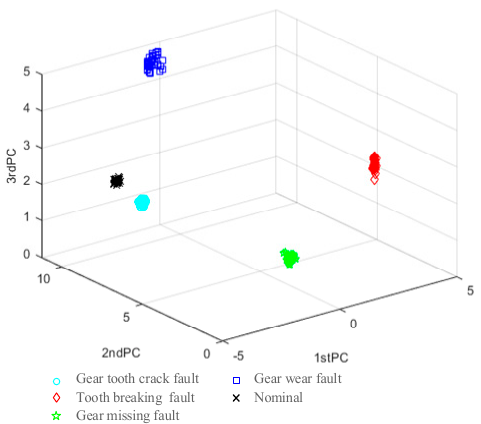
Figure 7. Clustering result of gear fault features under condition 1.